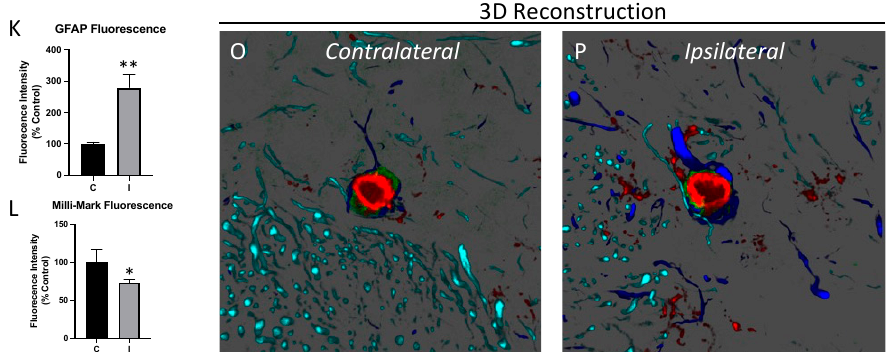
Figure 4. Ischemia-reperfusion injury induces changes in the NVU. The NVU was stained with lectin